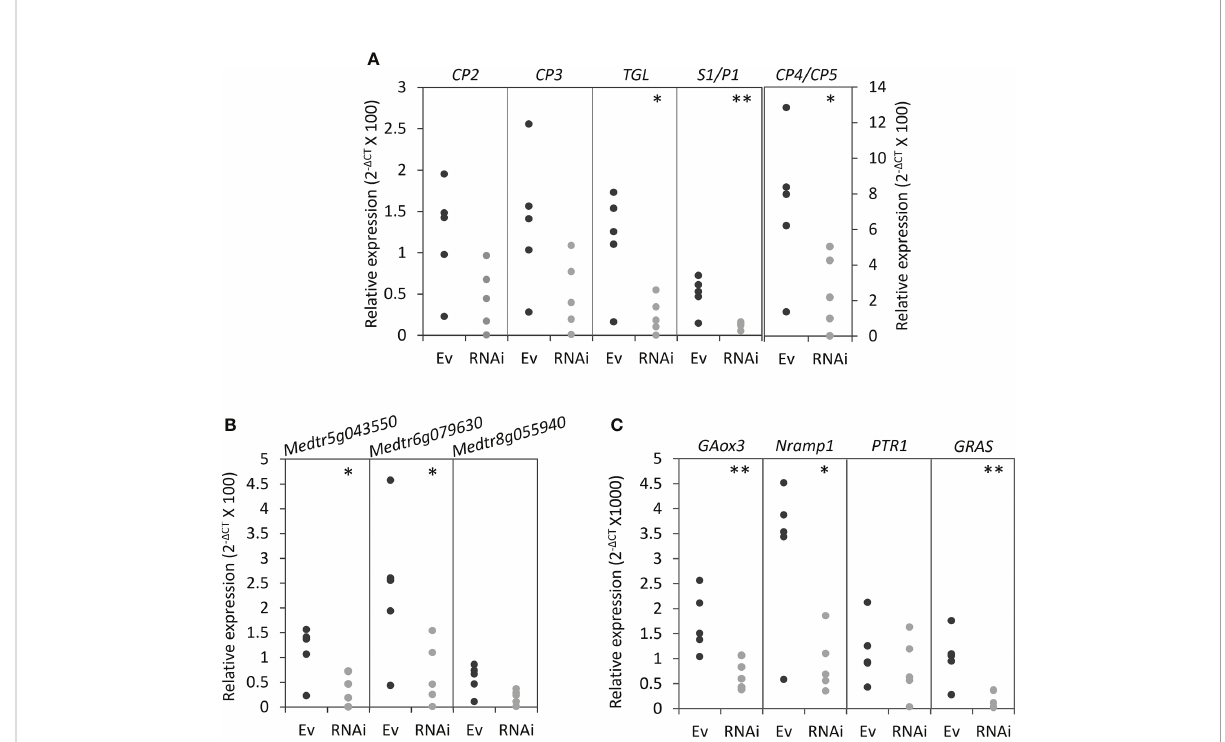
FIGURE 5 Transcript levels of genes associated with arbuscule degeneration and potential target genes of NF-Y protein complexes in MtNF-YC6 / C11 RNAi roots. (A) The relative expression level of cysteine protease genes ( CP s), triacylglycerol lipase ( TGL ) and nuclease S1 ( S1/P1 ). (B) The relative expression level of chitinase genes. (C) The relative expression level of potential target genes of NF-Y complexes. The dark and light gray dots mean Ev and RNAi samples, respectively. n = 5. Student ’ s t test evaluated the difference between Ev and RNAi. *p<0.05,